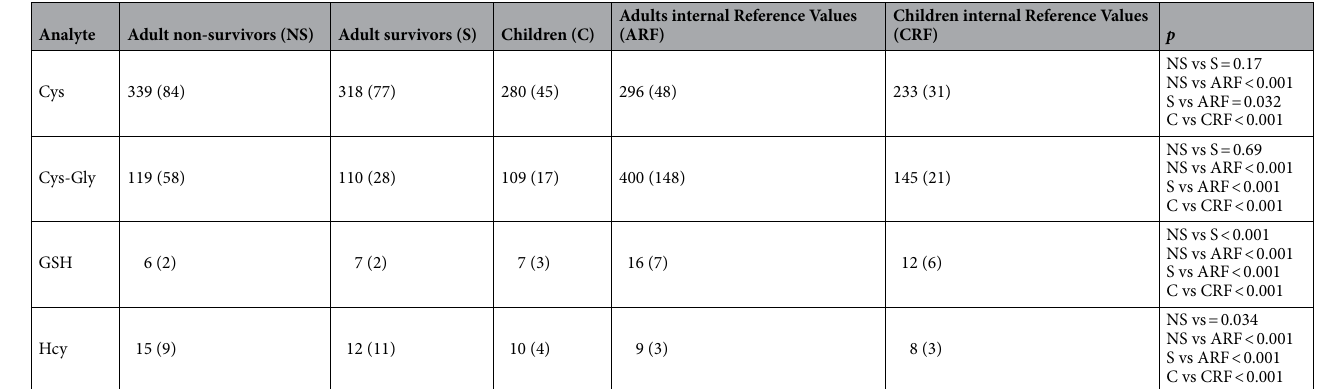
Table 3. Comparative thiols levels between adult non-survivors (NS), adult survivors (S), and children (C). Values are expressed as μmol/L; mean (standard deviation), or median (inter-quartile range, IQR) are reported.